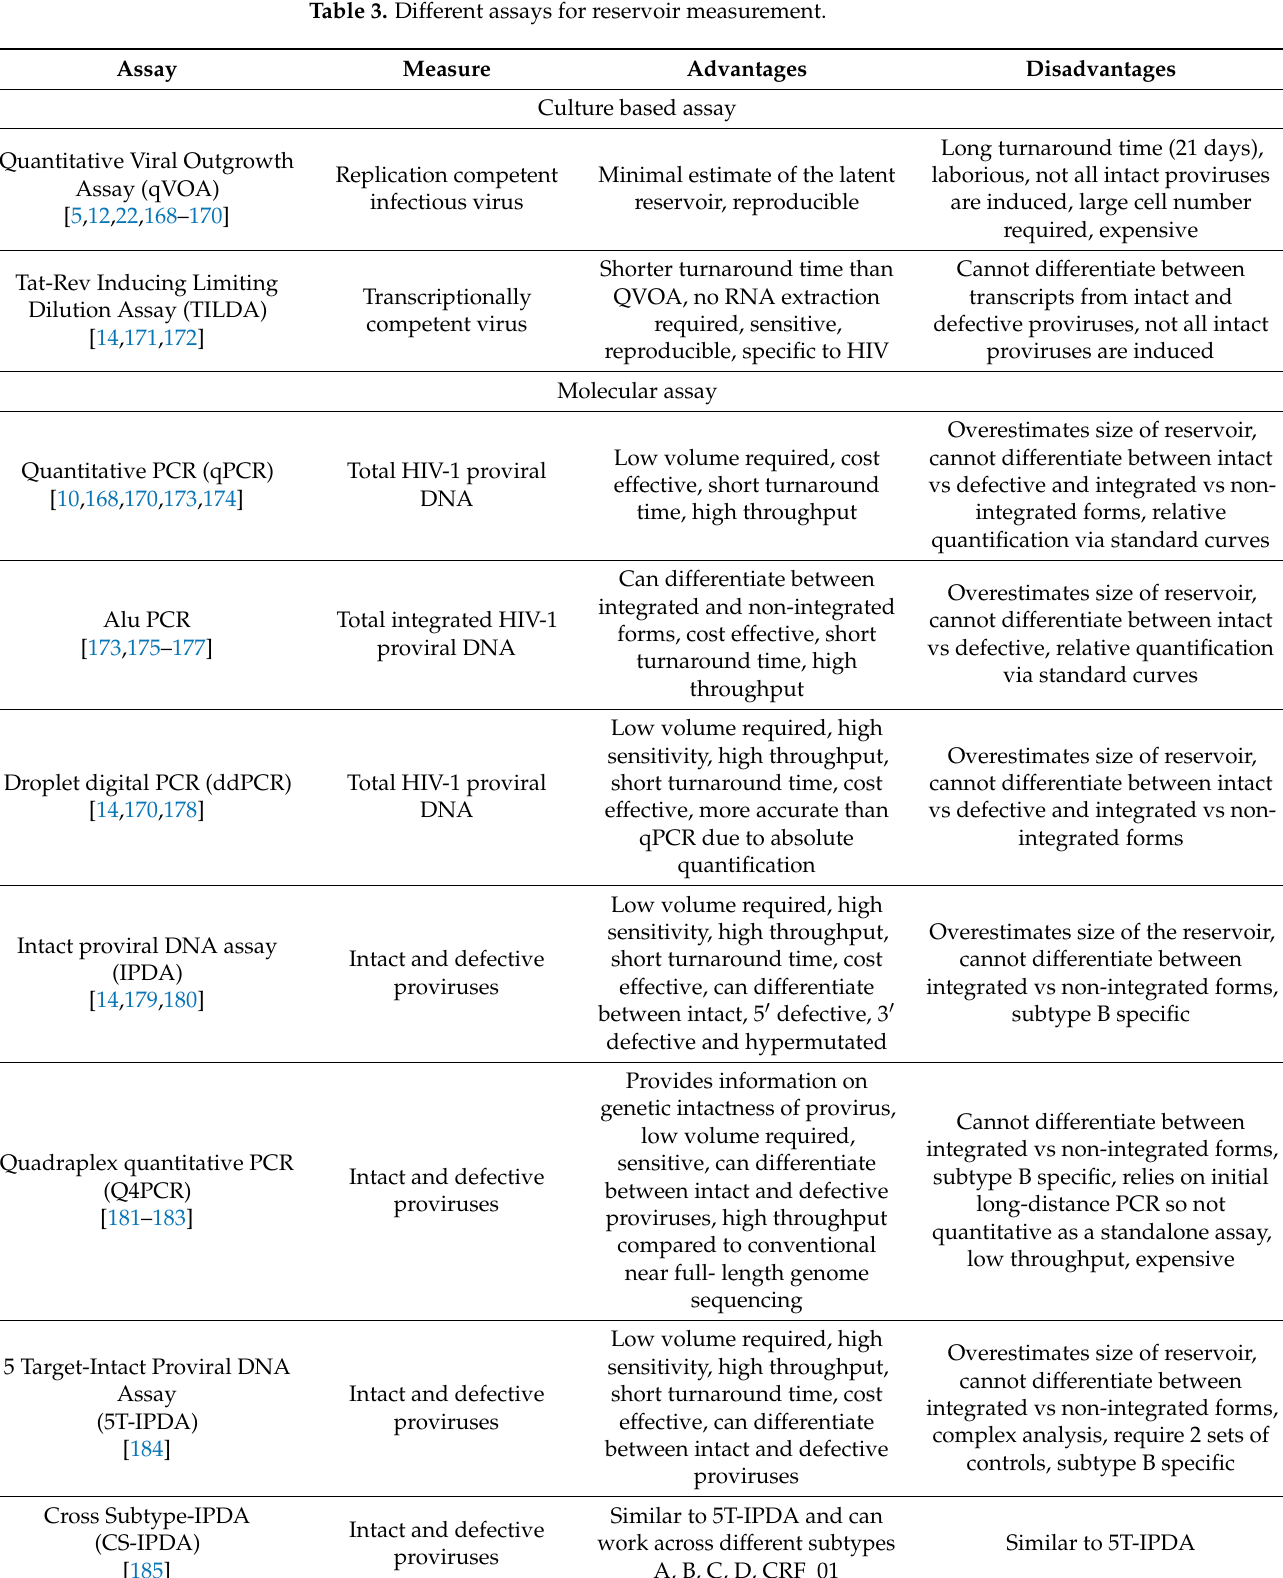
Table 3. Different assays for reservoir